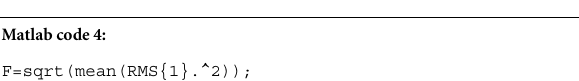
FIGURE 2 |The time series multifractal ( upper panel ), monofractal ( middle panel ), and whitenoise ( lower panel ) with zero average ( red dashed lines ) and ± 1 RMS ( red solid lines ). All time series have equal